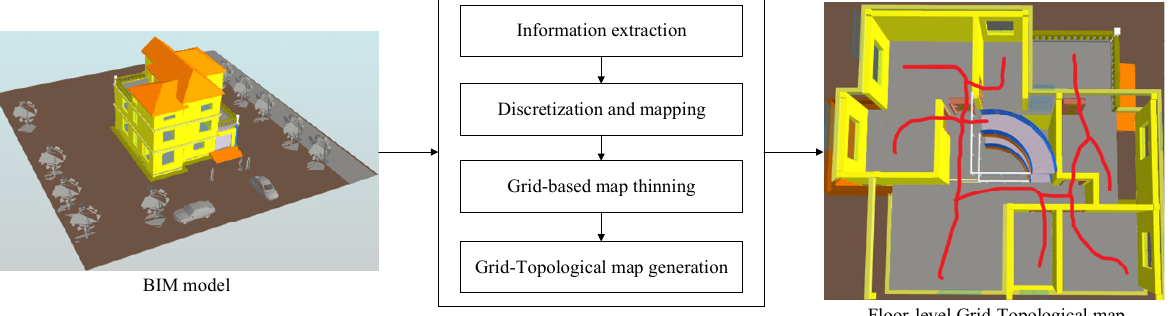
Figure 1. The procedures of generating the floor-level Grid-Topological map. Since the Topological map is generated from the grid-based map, it can be combined to generate a hybrid map, termed Grid-Topological map. The Grid-Topological map enables users to identify any point in the building accurately and compute the shortest path Grid-Topological map with an example. In Figure 2a, the building elements are extracted and projected into a plane with N × N grids. Figure 2b shows the grid-based map by discretizing and mapping all building elements on the grid plane. The gray grids are occupied, while the white ones are passable. The topological map is obtained by thinning the passable grids. The left grids are marked as red in Figure 2c. The thinned grid-based indoor map is processed by topological linking. Figure 2d shows the Grid-Topological map, which jointly includes both the grid-based map and the topological